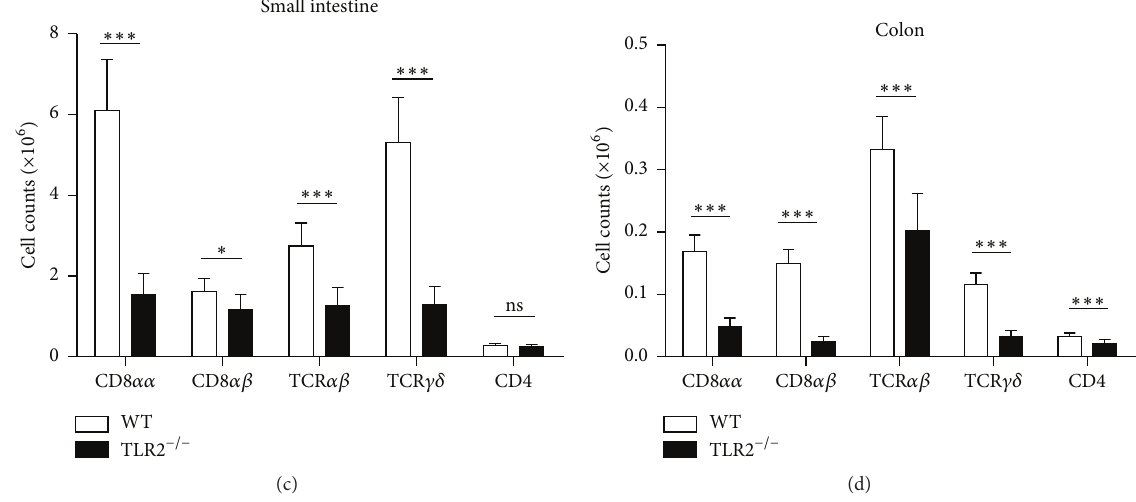
Figure 2: Changes in the phenotypes of intraepithelial lymphocyte (IEL) in TLR2 −/− mice. Cell populations are expressed as the percentage of gated cells with different cell phenotype markers. The data were obtained from CD45-positive cells. (a and b) The IELs from small intestine (a) or colon (b) of mice were stained as indicated. Expression of CD8 𝛼 and CD8 𝛽 chains on CD45 + IELs. Cells were stained with anti-CD45, anti-CD8 𝛼 , and anti-CD8 𝛽 mAbs and positively gated by CD45. Expression of TCR 𝛼𝛽 and TCR 𝛾𝛿 on CD45 + IELs. Cells were stained with anti-CD45, anti-TCR 𝛼𝛽 , and anti-TCR 𝛾𝛿 mAbs and positively gated by CD45. Expression of CD8 𝛼 and CD4 on CD45 + IELs. Cells were stained with anti-CD45, anti-CD8 𝛼 , and anti-CD4 mAbs and positively gated by CD45. (c and d) The absolute numbers of the indicated IEL subsets in the small intestine (c) or colon (d) of individual mice. The absolute number of each subset was calculated by multiplying total number of IELs by the percentage of each subset. Five mice per group. Representative of three experiments. ∗ 𝑃 < 0.05 ; ∗∗∗ 𝑃 < 0.001